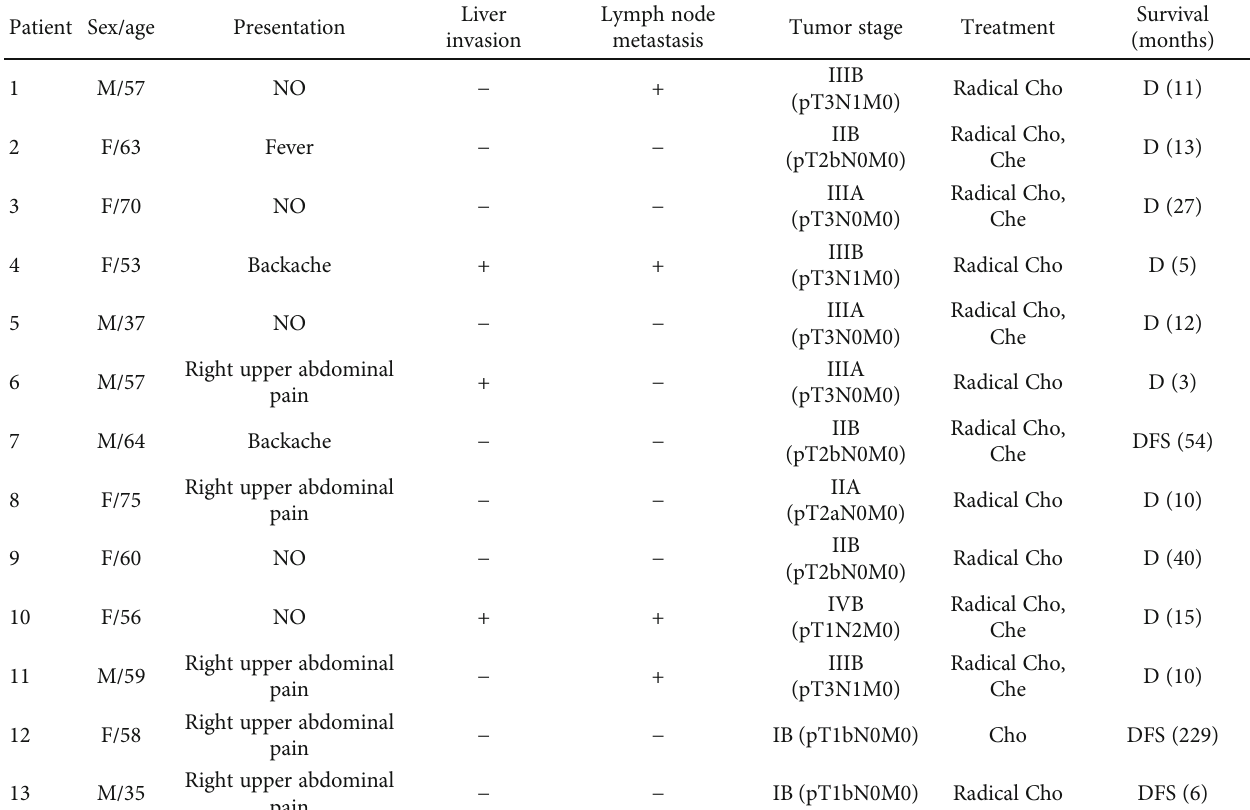
Table 1: Clinicopathological characteristics of the 13 patients with GB-NENs.